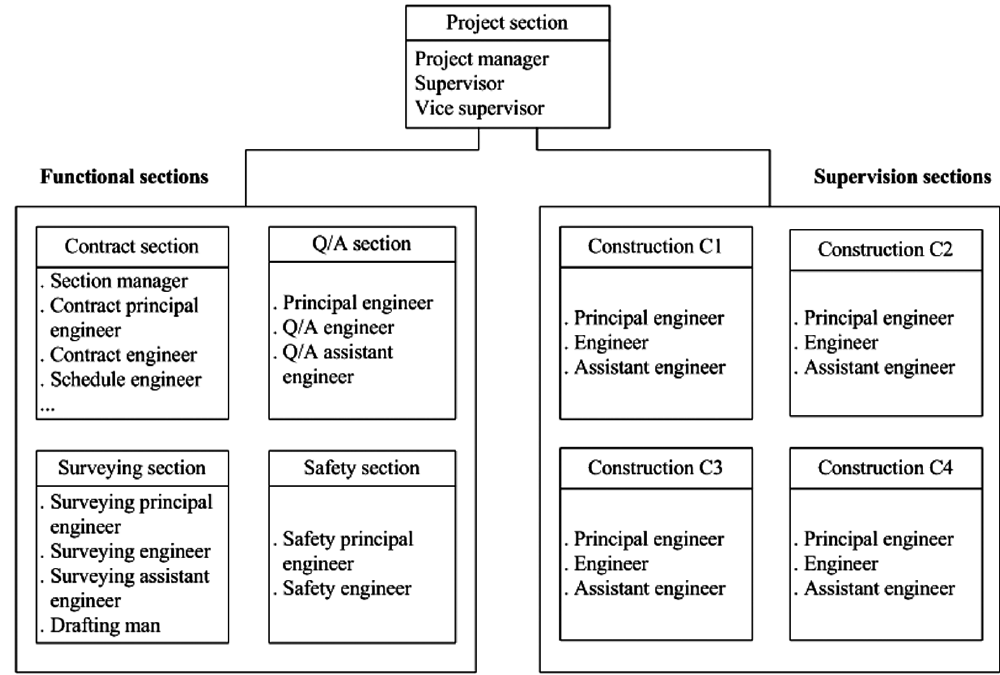
Fig. 1. Example of the organization of a mega supervision